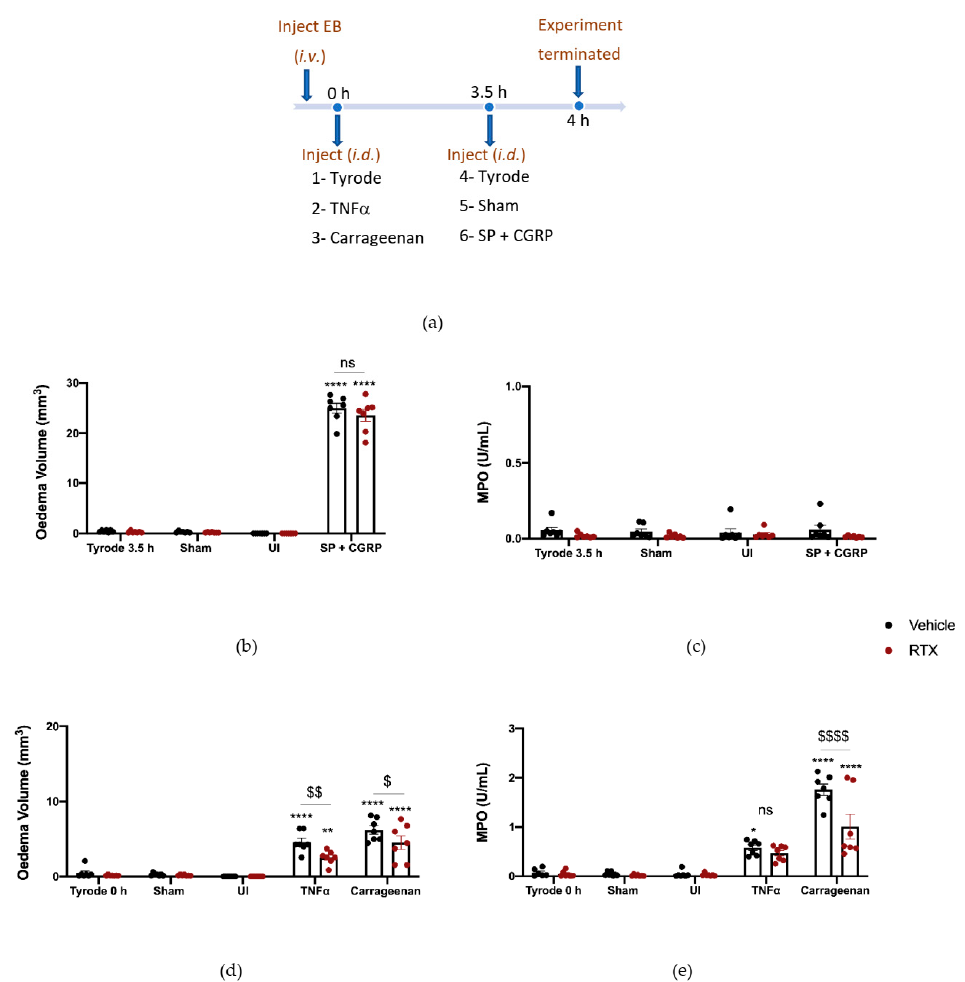
Figure 3. Sensory nerve depletion reduces oedema formation induced by tumour necrosis factor alpha, TNF α , and carrageenan, but only neutrophil accumulation induced by carrageenan over 4 h. ( a ) Timeline for studying the effect of sensory nerve depletion on TNF α and carrageenan-induced inflammation over 4 h in Resiniferatoxin (RTX)-pre-treated mice and vehicle-pre-treated mice. Oedema volume ( b ) and neutrophil accumulation ( c ) measured after injecting SP (300 pmol/50 µ L) with CGRP (20 pmol/50 µ L i.d.) for the last 30 min of the protocol. ( d ) Oedema volume and ( e ) neutrophil accumulation measured 4 h after injecting TNF α (100 ng/50 µ L i.d.) and carrageenan (100 µ g/50 µ L i.d.) in vehicle or RTX (0.3 mg/kg s.c.) pre-treated mice. Results are shown as mean ± SEM ( n = 7). Two-way ANOVA with Bonferroni’s post hoc test. * p < 0.05, ** p < 0.01 and **** p < 0.0001 are compared to Tyrode 0 h or Tyrode 3.5 h. $ p < 0.05, $$ p < 0.01 and $$$$ p < 0.0001 are compared to Vehicle TNF α or